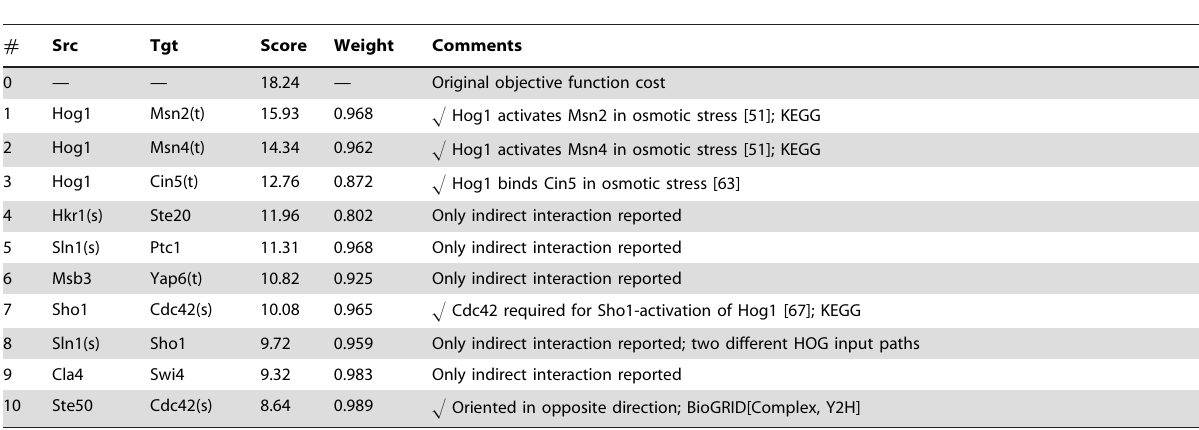
Table 3. Top 10 predictions for Shortcuts-X using the Greedy